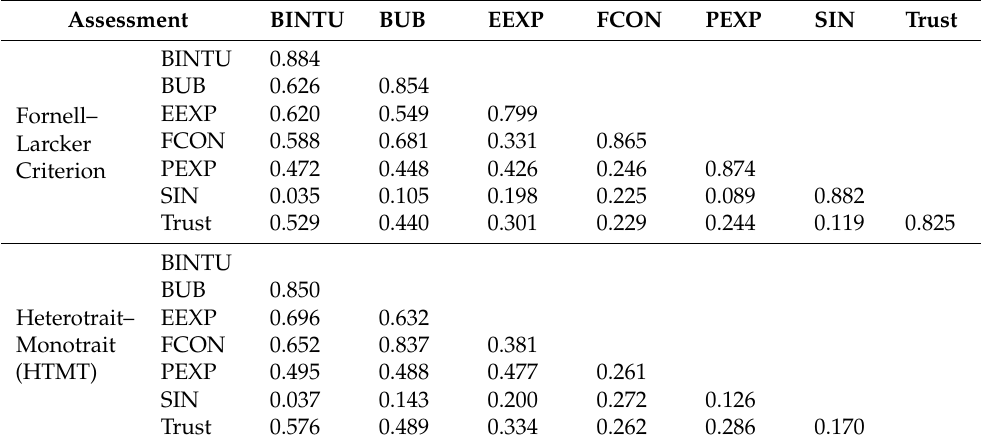
Table 6. Fornell–Larcker criterion and heterotrait–monotrait (HTMT)